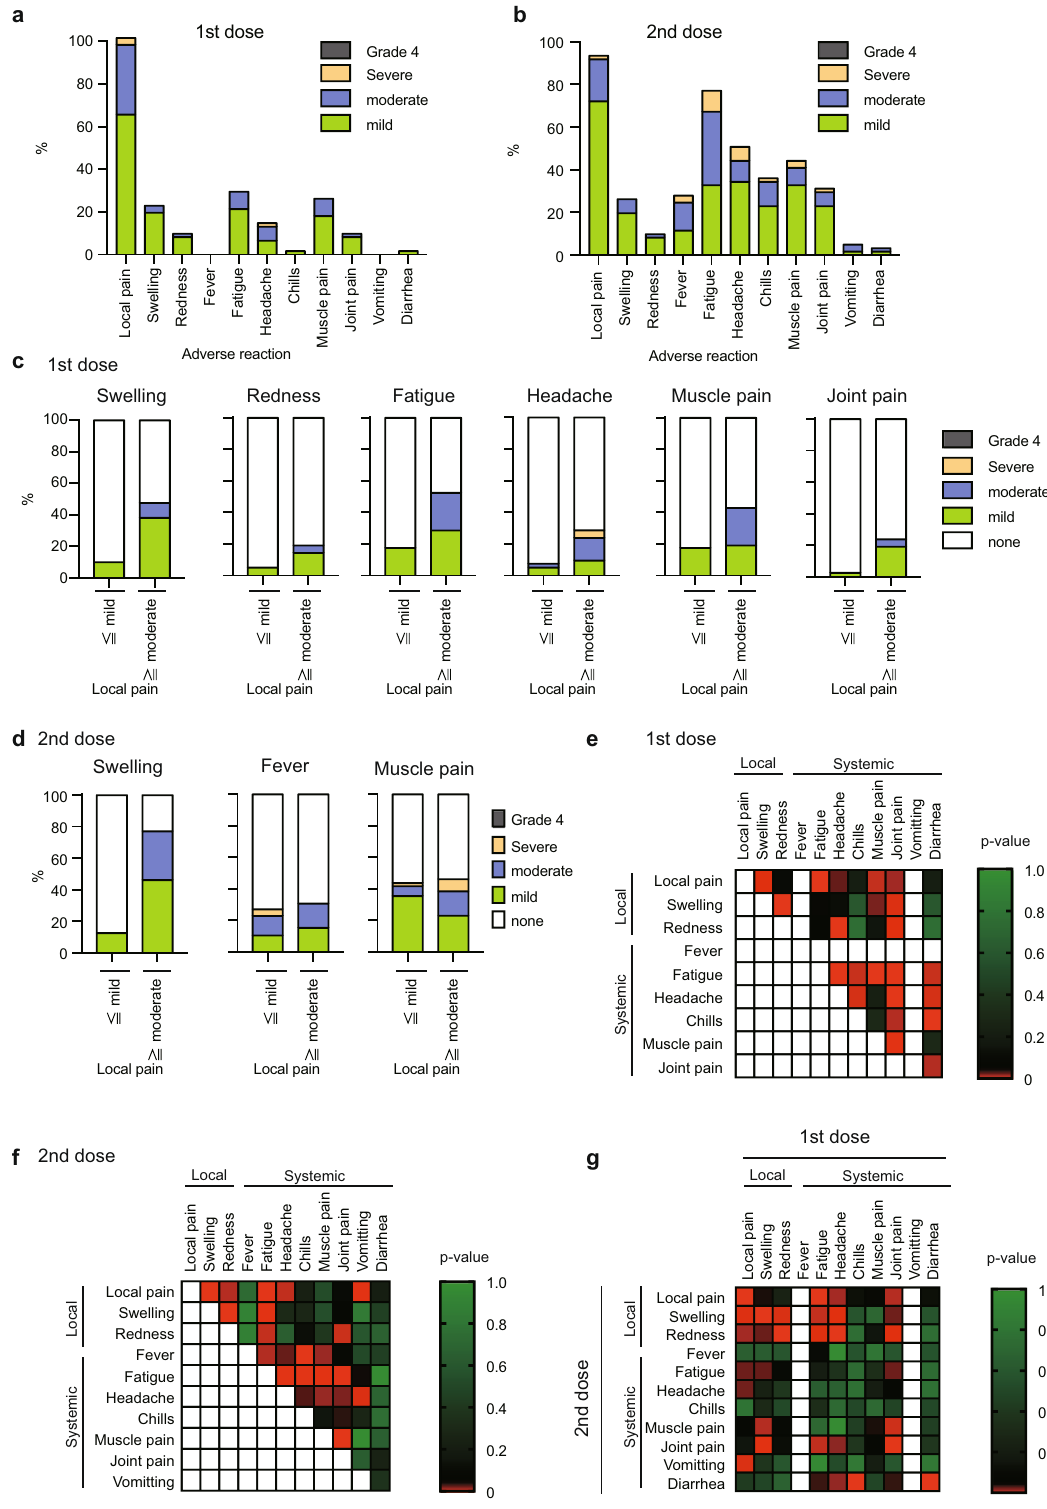
Fig. 2 Adverse reactions after the fi rst and second doses. a , b Data on local and systemic symptoms of 61 patients within 1 week after the fi rst ( a ) and second ( b ) doses were collected as described in the “ Methods ” . The data are shown as percentages of the degree of each symptom ( n = 61). c , d Subjects were classi fi ed into two groups, ≦ mild (no or mild local pain) and ≧ moderate (mild, severe, and grade-4 local pain), and percentages of each symptom degree are shown. e – g Degrees of each symptom were scored as no (0), mild (1), moderate (2), severe (3), and grade 4 (4), and p -values of the correlation coef fi cient of scores between two symptoms after the fi rst dose ( e ), after the second dose ( f ), and after the fi rst and second doses ( g ) were calculated. P -values are shown as heat maps. Red color represents statistical signi fi cance ( p <